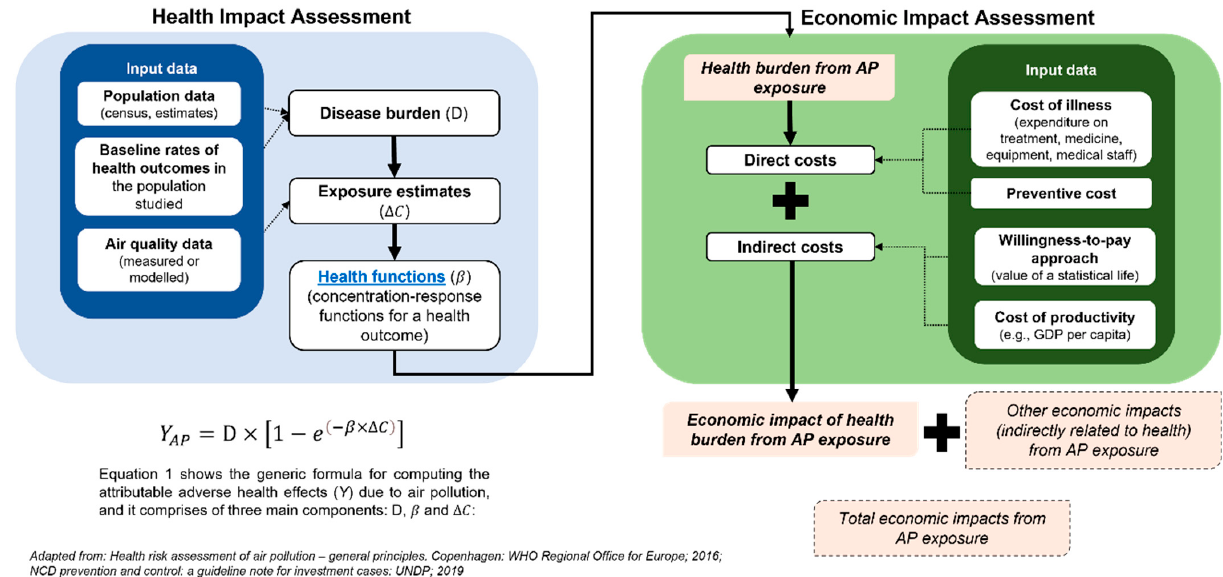
Figure 2. Assessment framework used to quantify the health burdens and economic burdens at- tributable to air pollution. The ∆ C is the subtraction result of the recent PM 2.5 level ( c ) and the counterfactual PM 2.5 ( c f ) selected to calculate the health impacts.